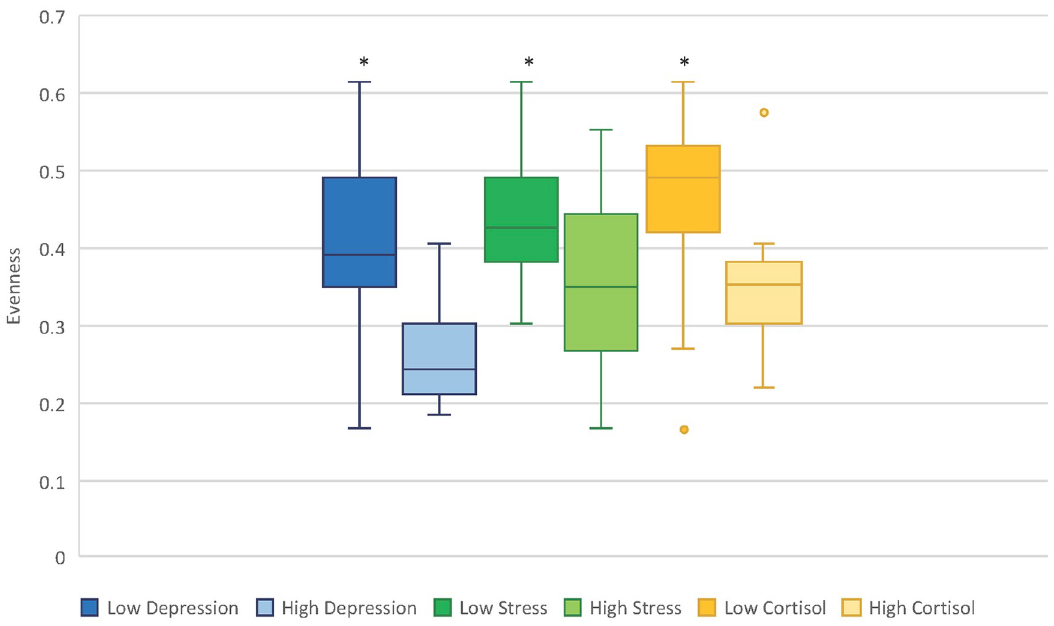
Fig 2. High postpartum maternal depression, stress, and morning cortisol concentration significantly decrease Shannon’s Entropy in infant stool. � Indicates p �